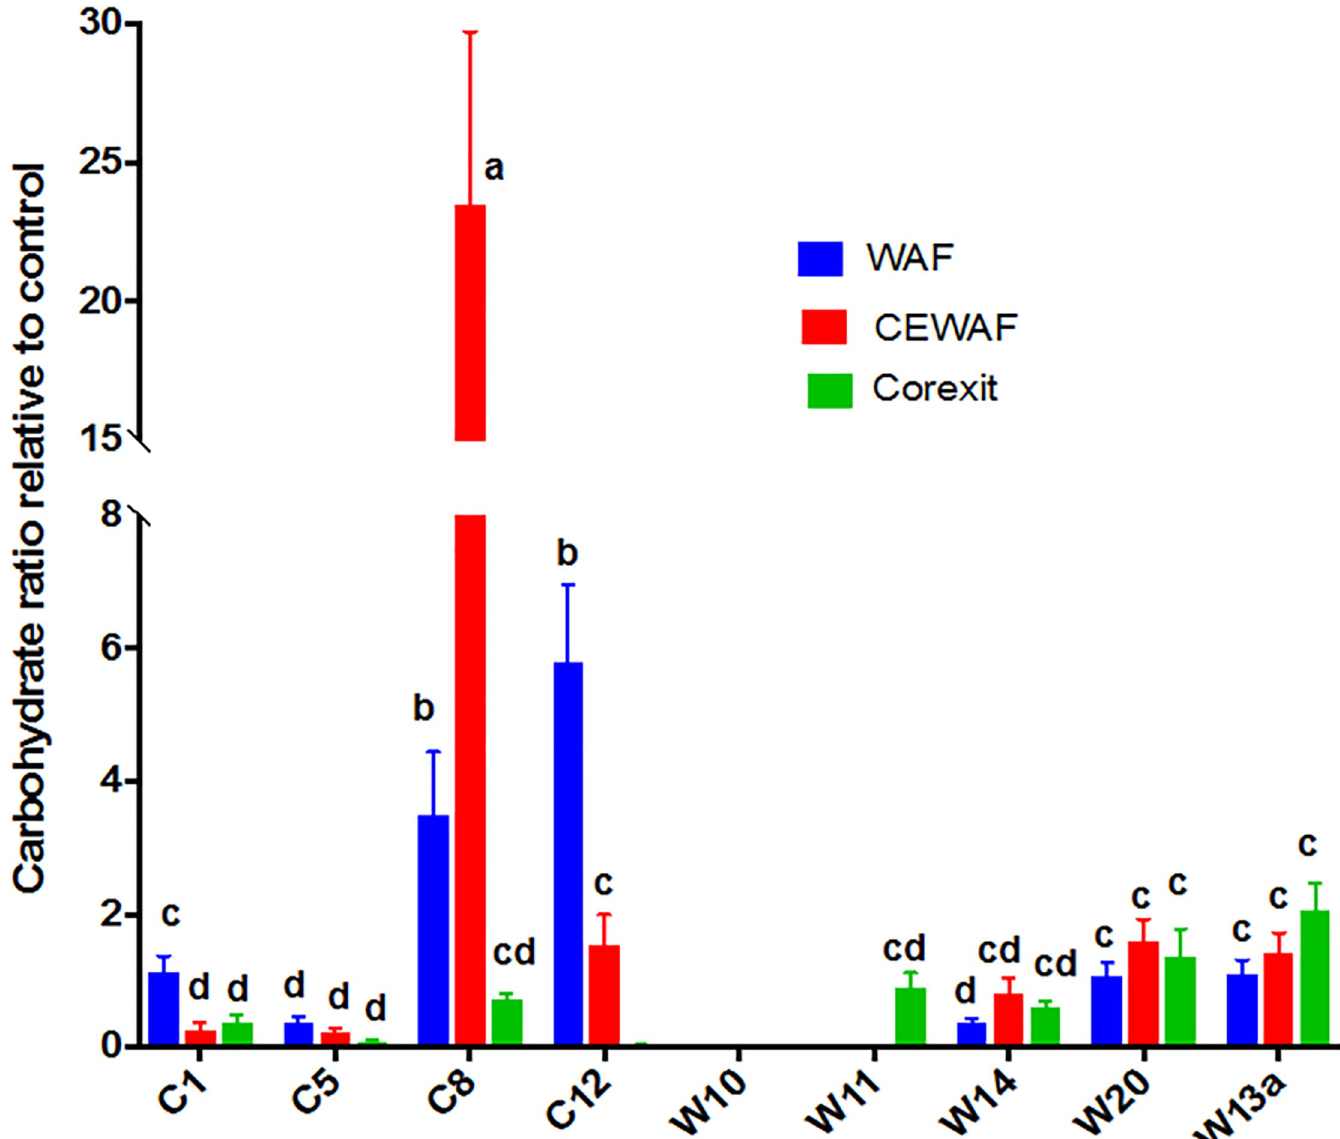
Fig 3. Production of carbohydrates by the isolates in WAF, CEWAF and Corexit after 4 d of incubation. All values are normalized to Control. Error bars represent the standard deviation of the replicates. Different letters above bars indicate significant differences among treatments (P < 0.05).